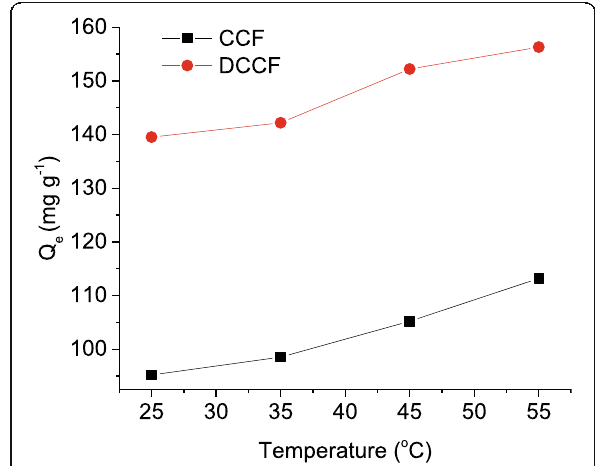
Fig. 9 Effect of temperature on equilibrium adsorbent capacity from initial concentration of 30 ppm and 10 mg adsorbent dosage